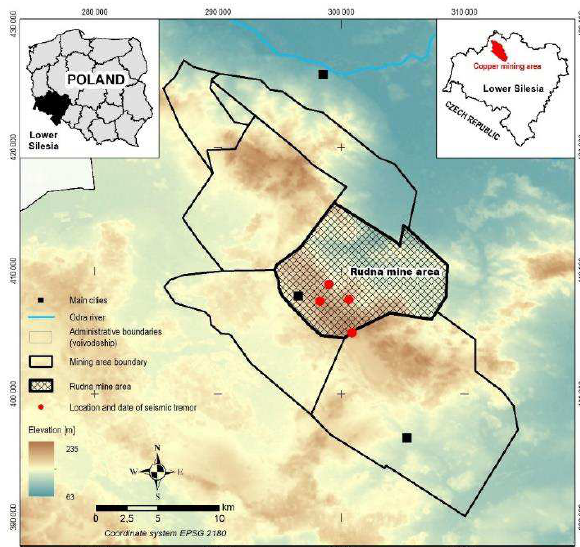
Figure 1. Location of the analysed seismic events in relation to Rudna mining ground